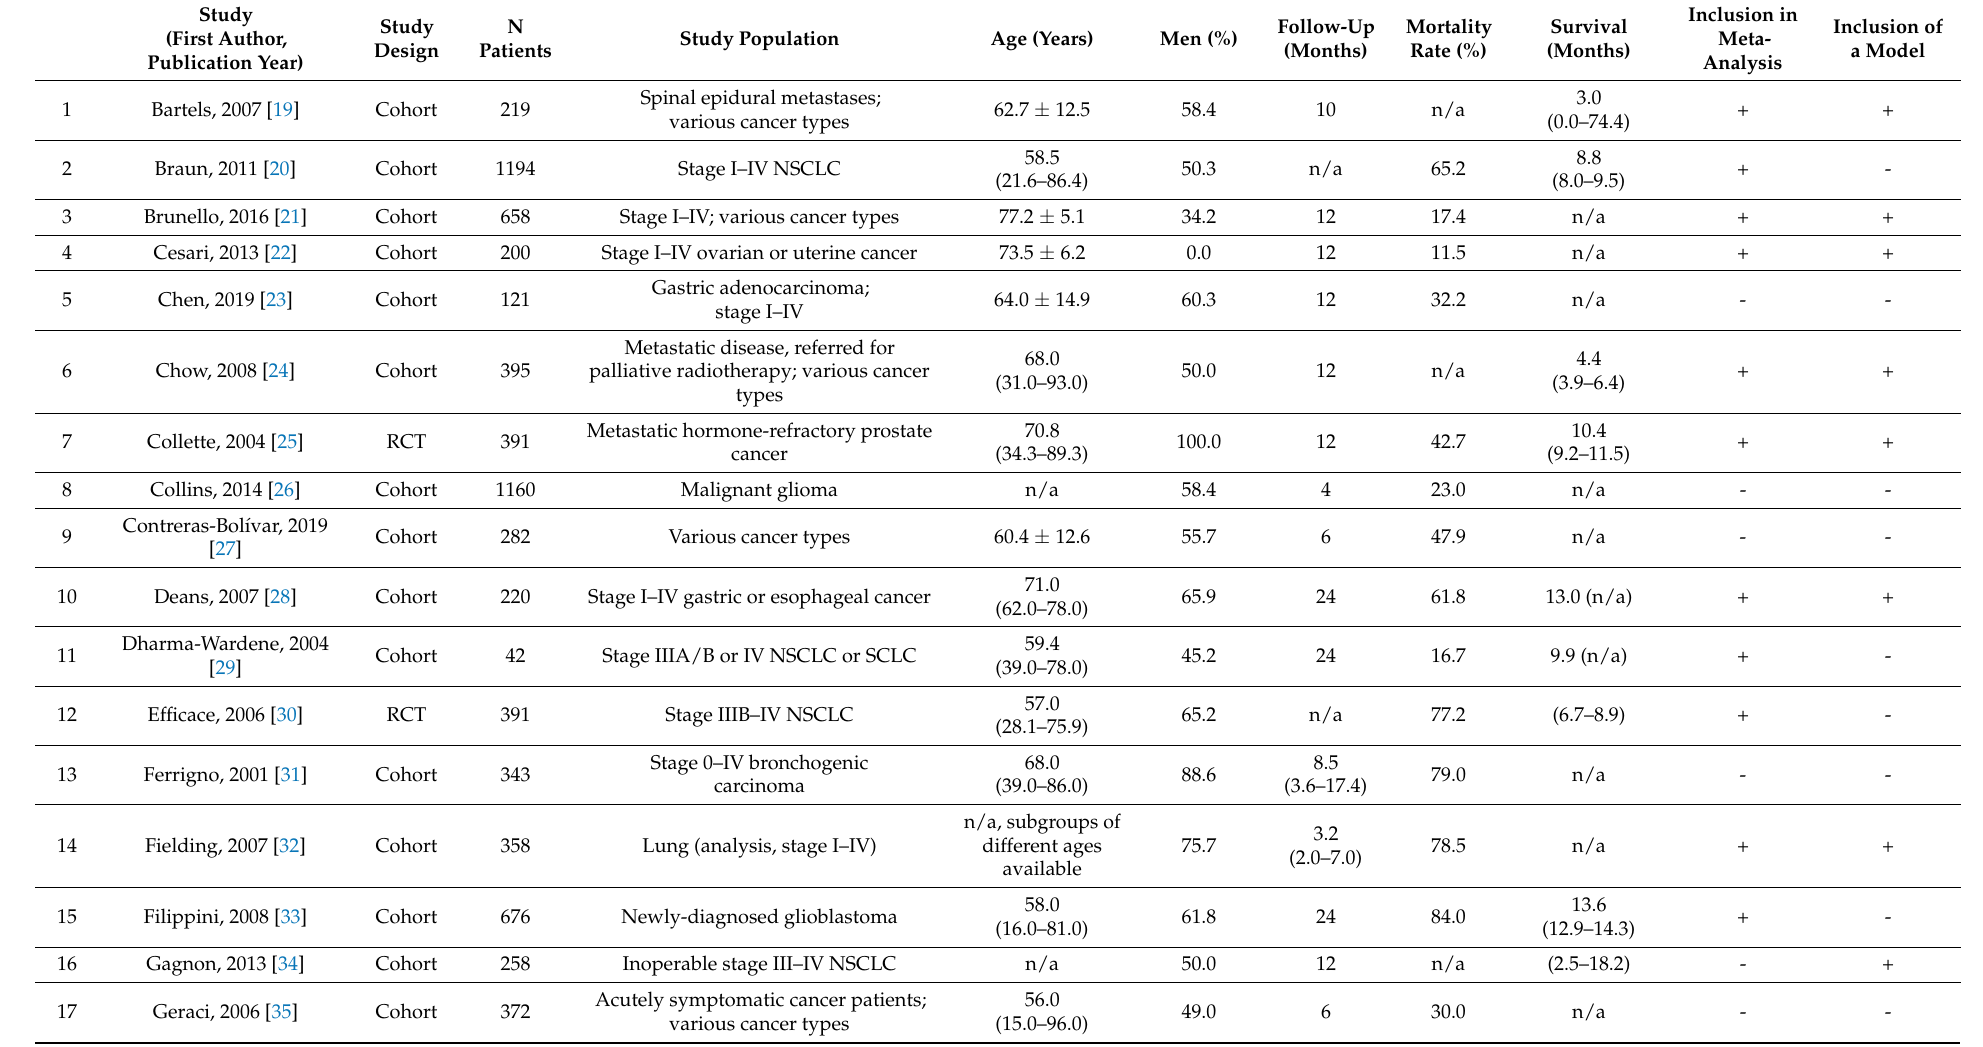
Table 1. Study characteristics of all 68 studies reporting predictors of mortality or prediction